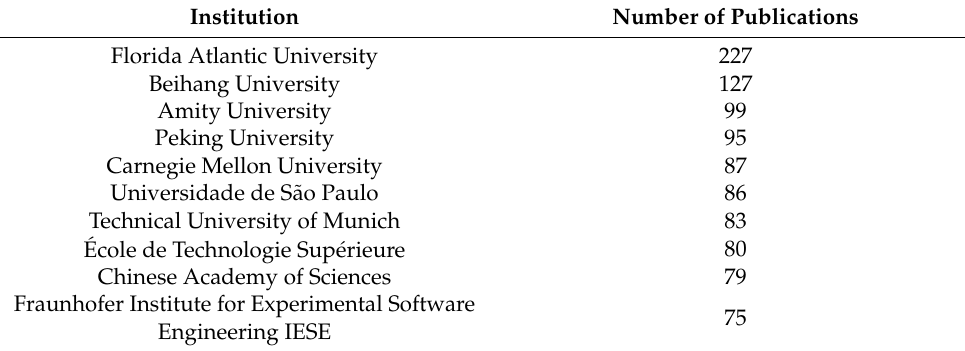
Table 2. Most productive institutions.